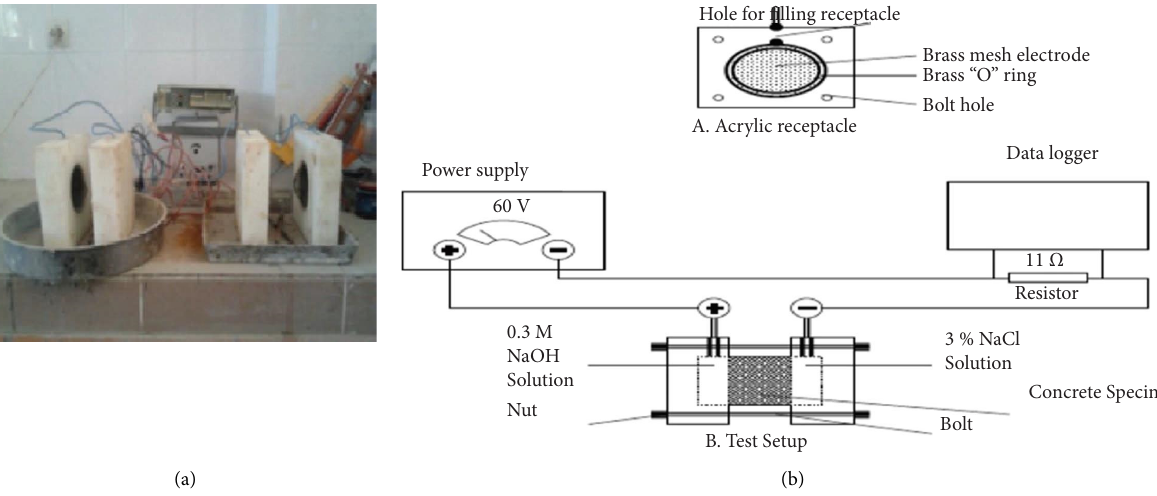
Figure 4: RCPT test setup: (a) a pictorial vision of the RCPT test setup and (b) a graphical show of the test setup for